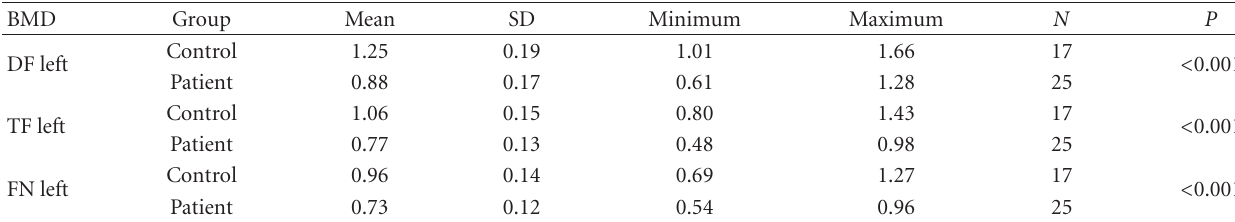
Figure 1: DF analysis by DXA. The square represents the studied site. Table 1: BMD values between groups, at left femoral